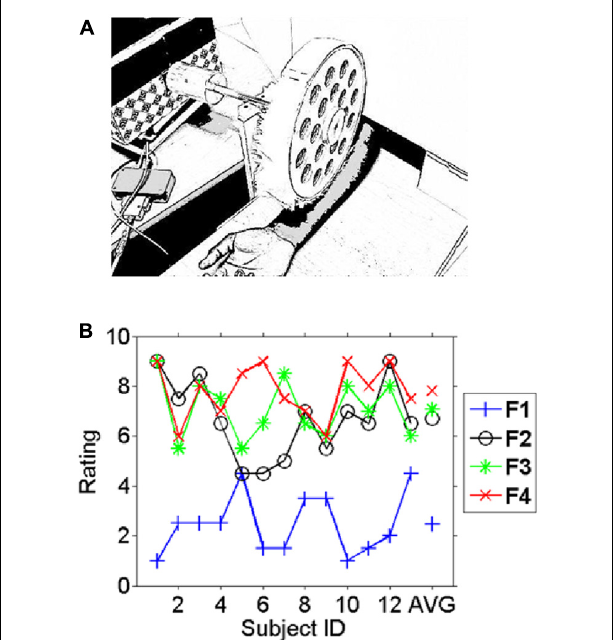
FIGURE 1 | Experimental setup and behavioral results. (A) The fabric caressing device (FCD) stimulated the right inner forearm during the experiment by rotational movements. In different blocks four different fabrics were mounted on the drum. Participants had no vision of either fabric or device as this was occluded. (B) The average pleasantness ratings (scale 1–9) for the different fabrics across participants (1–13) and the average across subjects on the very right (AVG). A high rating indicates a “pleasant” experience whereas a low rating indicates an unpleasant experience. Subjects consistently rated fabric 1 as the least liked and fabric 4 was on average the most liked fabric. Note the inter-individual variation